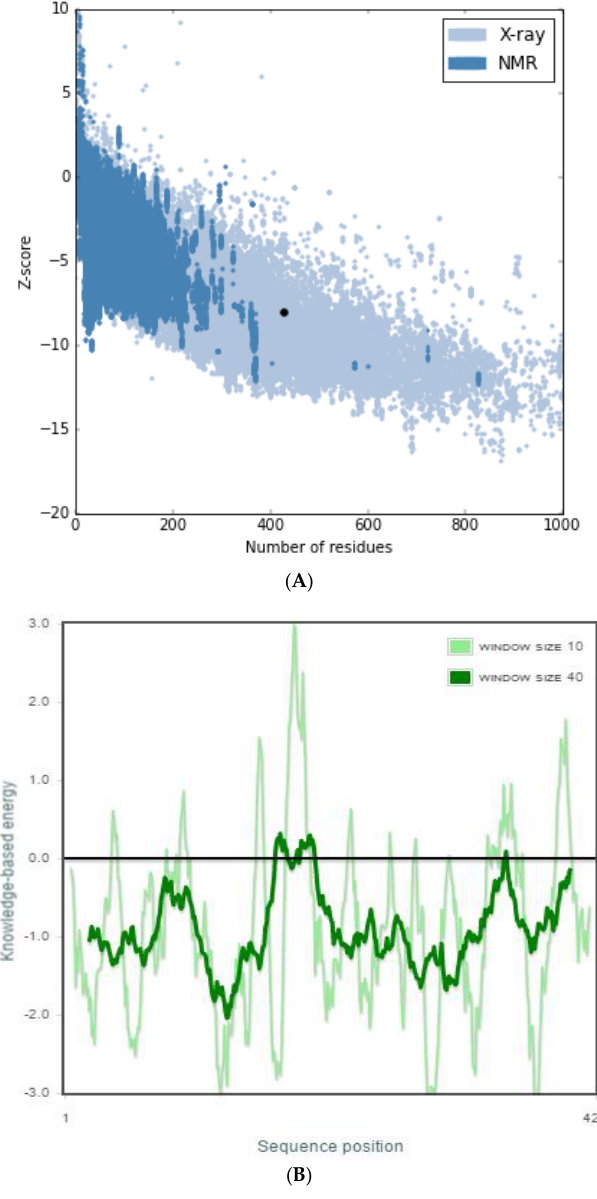
Figure 2. ProSA web z-score and energy graph of ICL modeled protein. ( A ) The Z-score of ICL (represented in dot) was present in the range of all protein chains in the Protein Data Bank determined by X-ray crystallography and nuclear magnetic resonance spectroscopy with respect to their sequence length. ( B ) Energy plot of the ICL protein